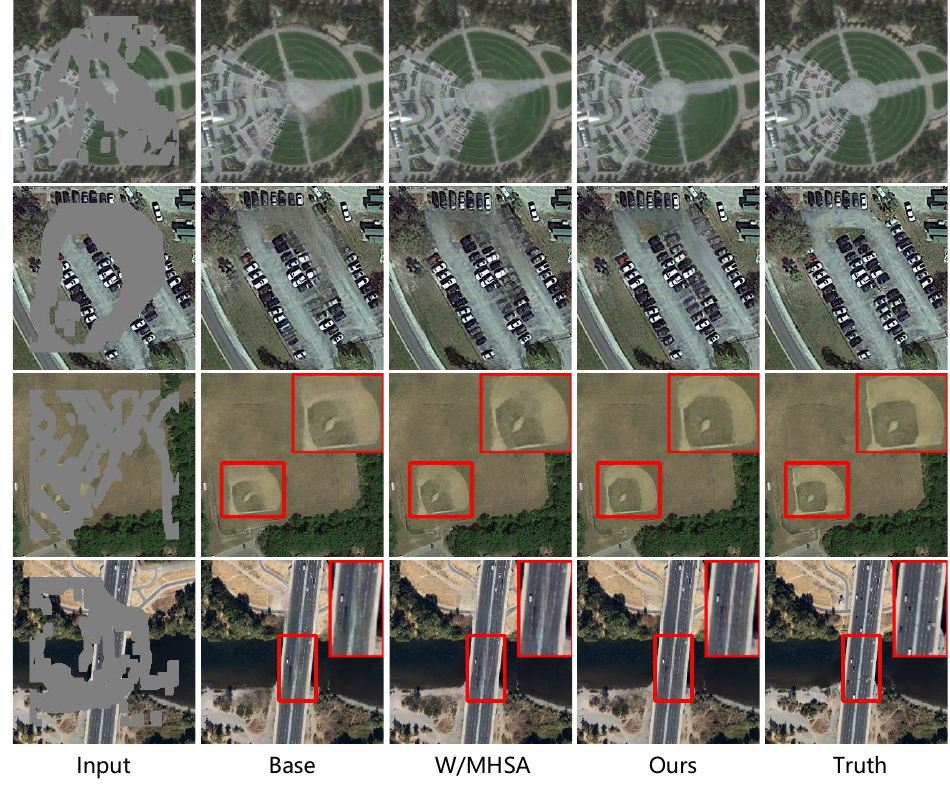
Figure 9. Visualization results of the effectiveness of our Ada-attention on the AID dataset. Please zoom in for